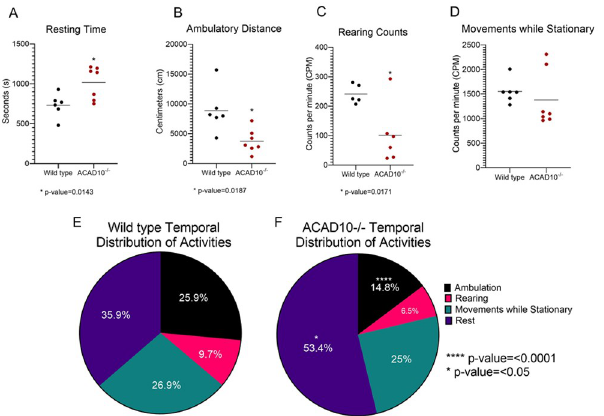
Fig 4. Open field measures for wild-type and Acad10- deficient mice. (A-D) Group averages (horizontal lines) of rest time, distance travelled, counts per minute (CPM) of rearing, and CPM of movements while stationary for wild-type (black dots) and Acad10 -deficient mice (red dots). During the 30-minute test, Acad10 -deficient animals spent statistically significantly more time resting (A), travelled a statistically significantly shorter distance (B), and reared statistically significantly less frequently (C) compared to wild-type mice of the same background (unpaired Student’s T-test with Welch’s correction, p-value < 0.05 to < 0.0005). The frequency of movements while stationary (D) did not differ significantly between Acad10 -deficient mice and wild-type mice of the same background (unpaired Student’s T- test with Welch’s correction). (E-F) Group averages of the percent of time of the total 30-minute test wild-type mice (E) and Acad10 -deficient mice (F) engaged in resting, ambulating, rearing, and movements while stationary (e.g., grooming). Acad10 -deficient mice spent a statistically significantly greater percent of time resting and, conversely, statistically significantly smaller percentage of time ambulating, rearing, or engaged in movements while stationary, compared to wild-type mice of the same background (unpaired Student’s T-test with Welch’s correction, p-value <